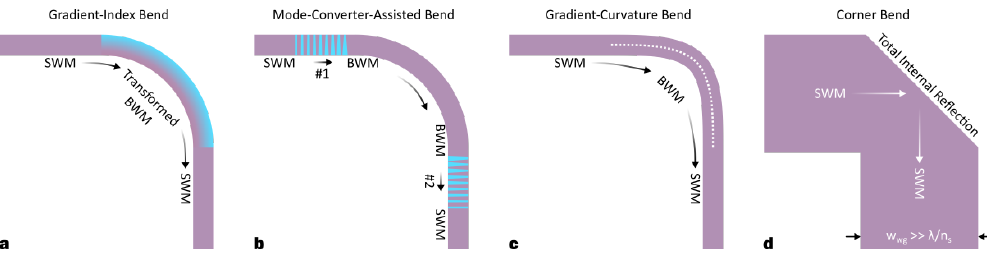
Figure 13. The schematics for different silicon multi-mode bends: ( a ) gradient index bend [167,168] , ( b ) mode converter-assisted bend [170] , ( c ) gradient curvature bend [171] , ( d ) corner bend [172] .